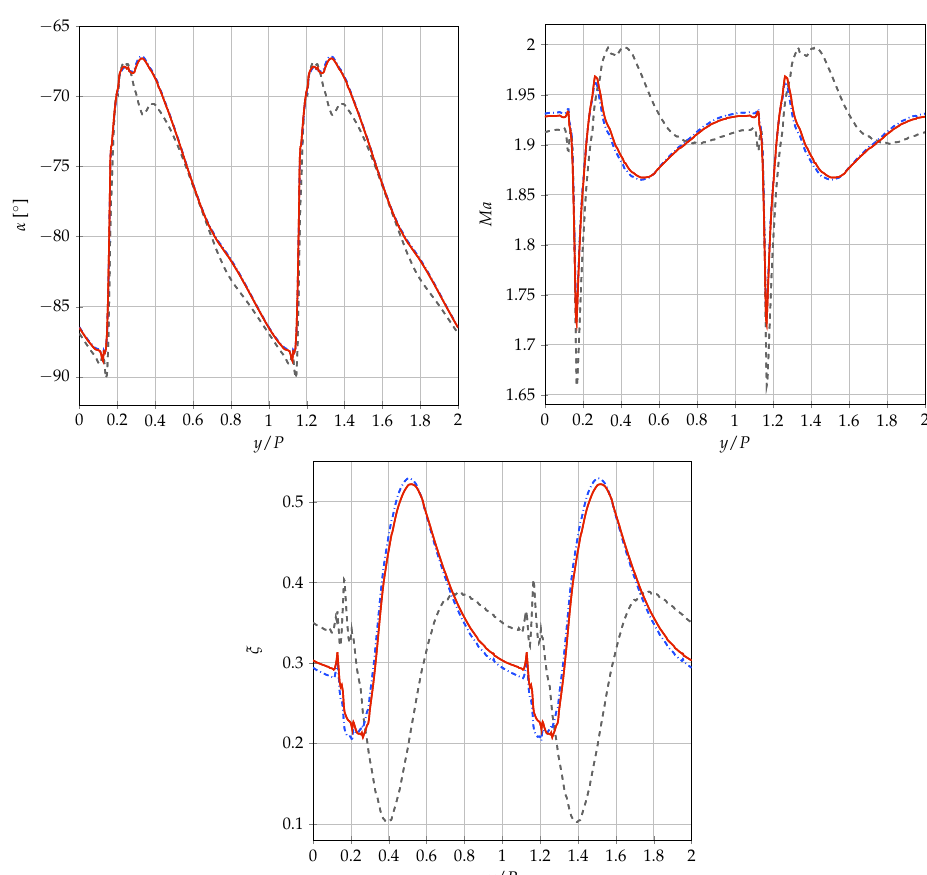
Figure 7. ORC nozzle. Outlet flow angle ( top left ), Mach number ( top right ), and total pressure loss coefficient ( bottom ) pitch-wise